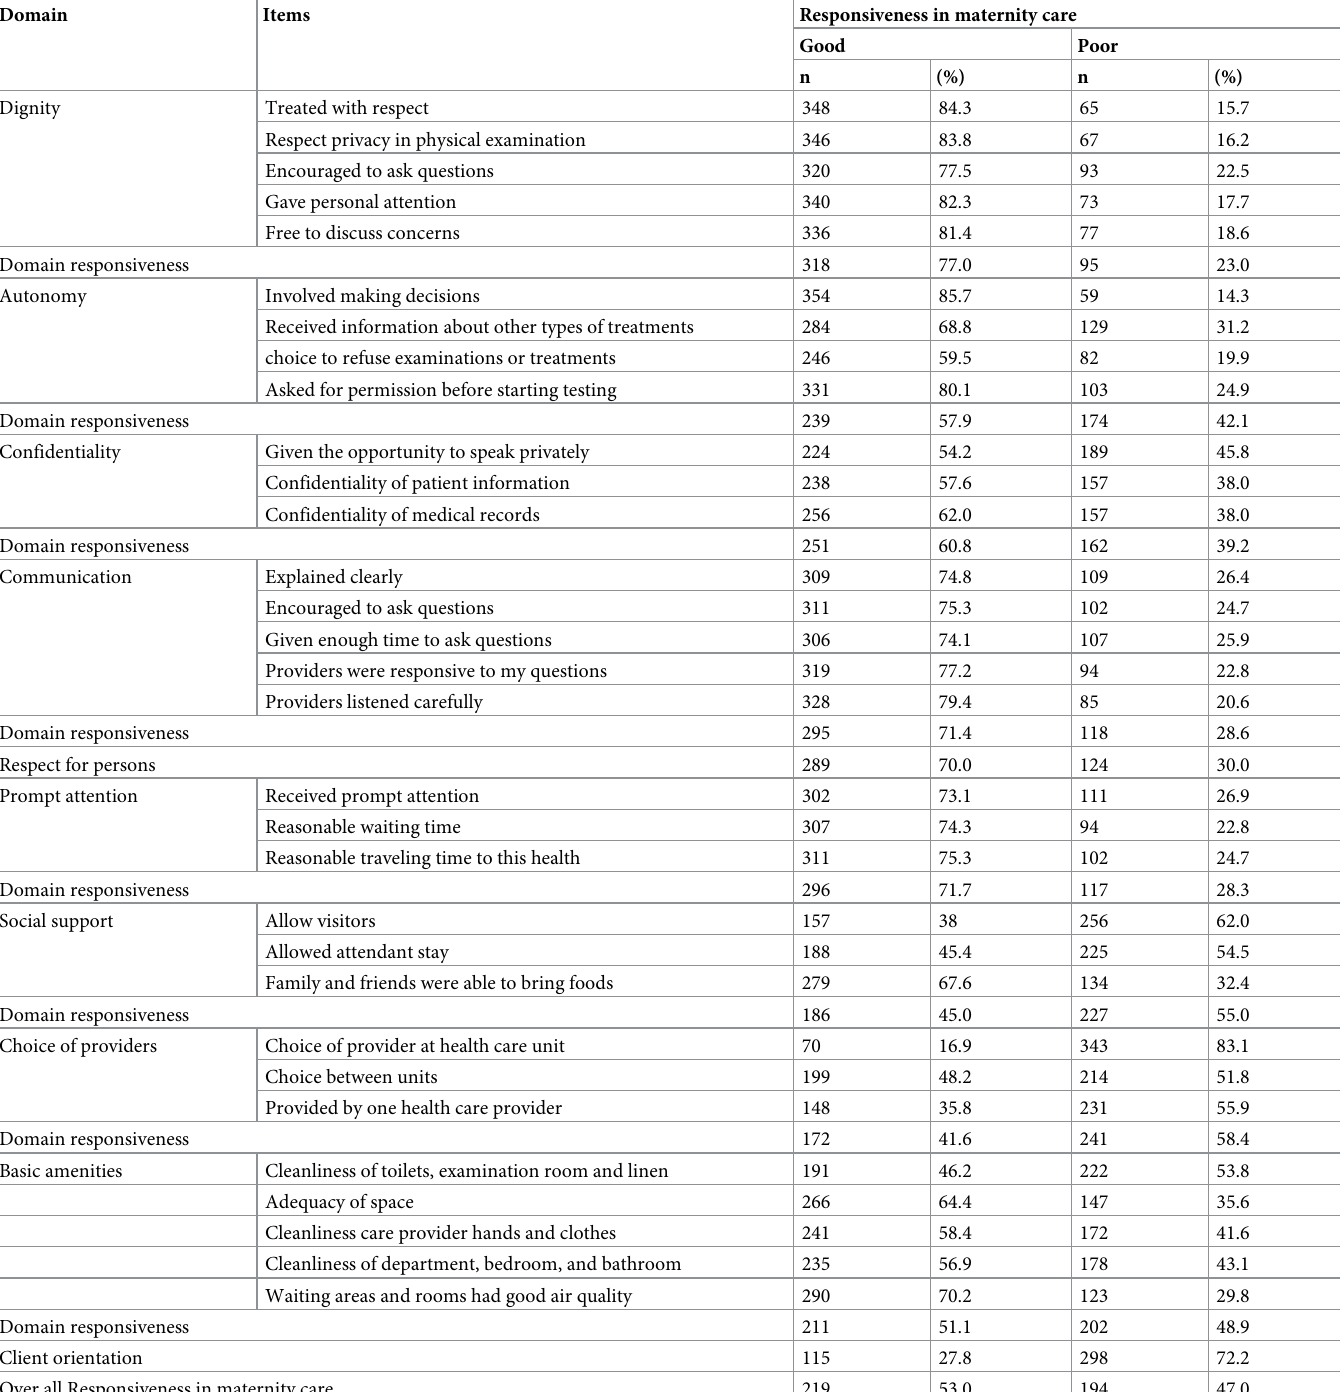
Table 2. Client reported responsiveness for each, respect, orientation and over all domain in the public maternity care, July 2020.